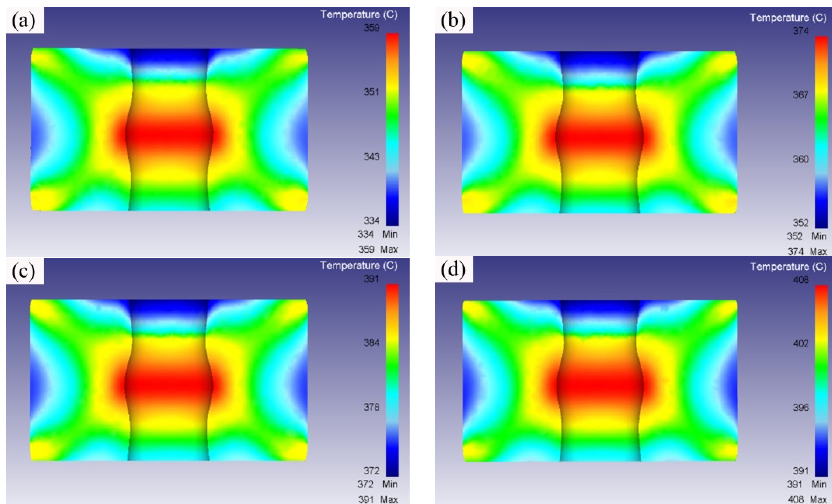
Figure 10. Temperature distribution of the forming parts at different temperatures of: ( a ) 320 °C, ( b ) 340 °C, ( c ) 360 °C, ( d ) 380 °C.